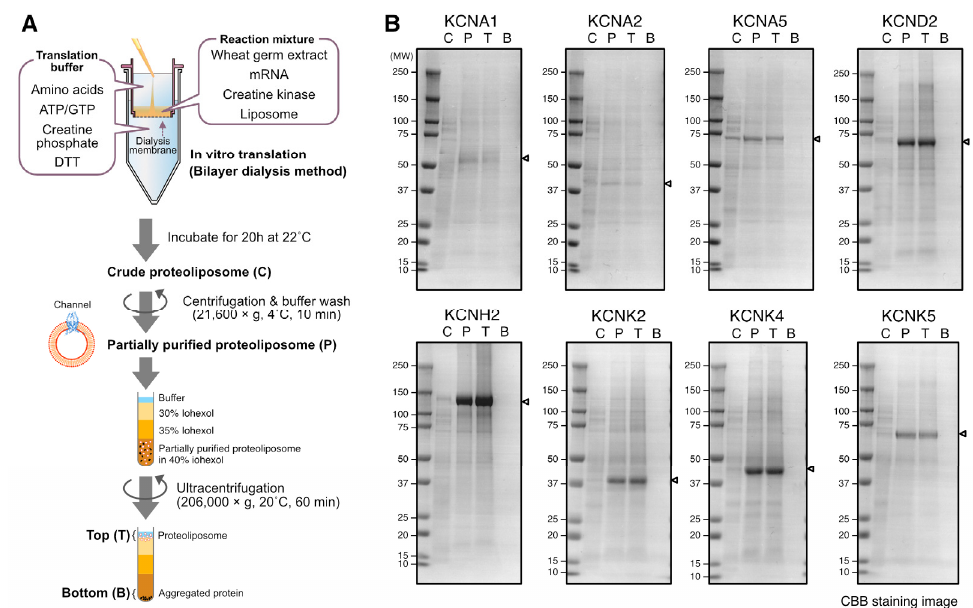
Figure 1. Interaction between cell-free synthesized channels and liposomes. ( A ) Scheme of cell-free synthesis and purification of channel proteoliposomes. ( B ). Proteoliposome samples subjected to density gradient centrifugation. Samples were subjected to SDS-PAGE with 5–20% gradient gels followed by Coomassie brilliant blue staining. C: crude translation mixture; P: partially purified proteoliposome; T: top fraction of density gradient; B: bottom fraction of density gradient. Arrowheads show the position of the band of each channel.